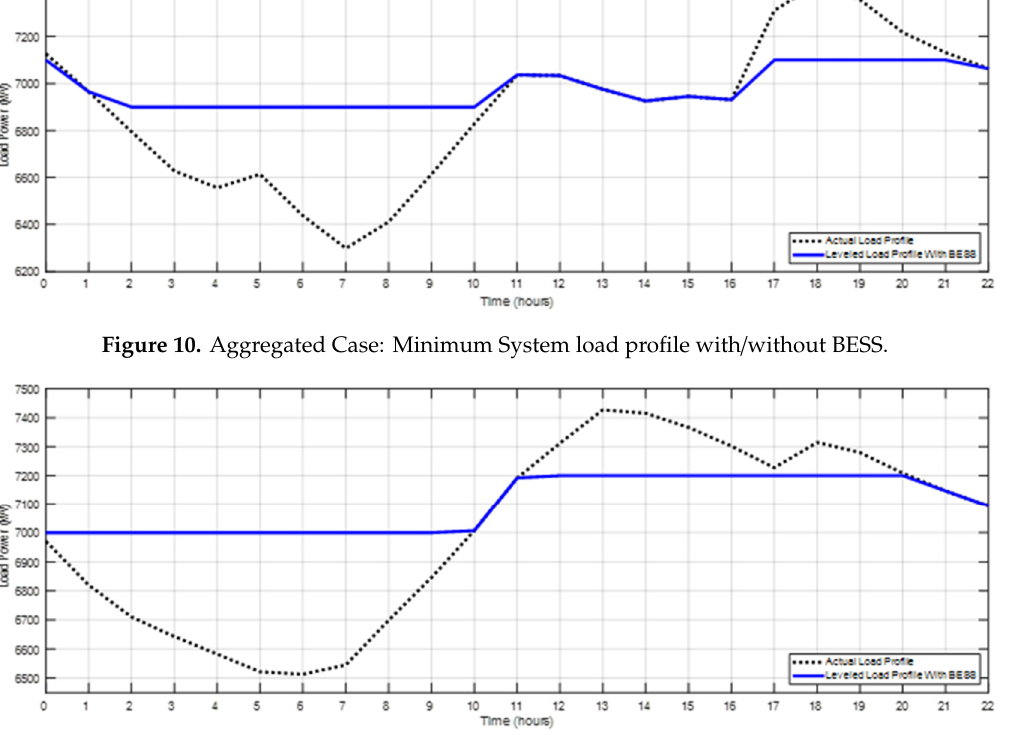
Figure 11. Aggregated Case: Maximum System load profile with / without